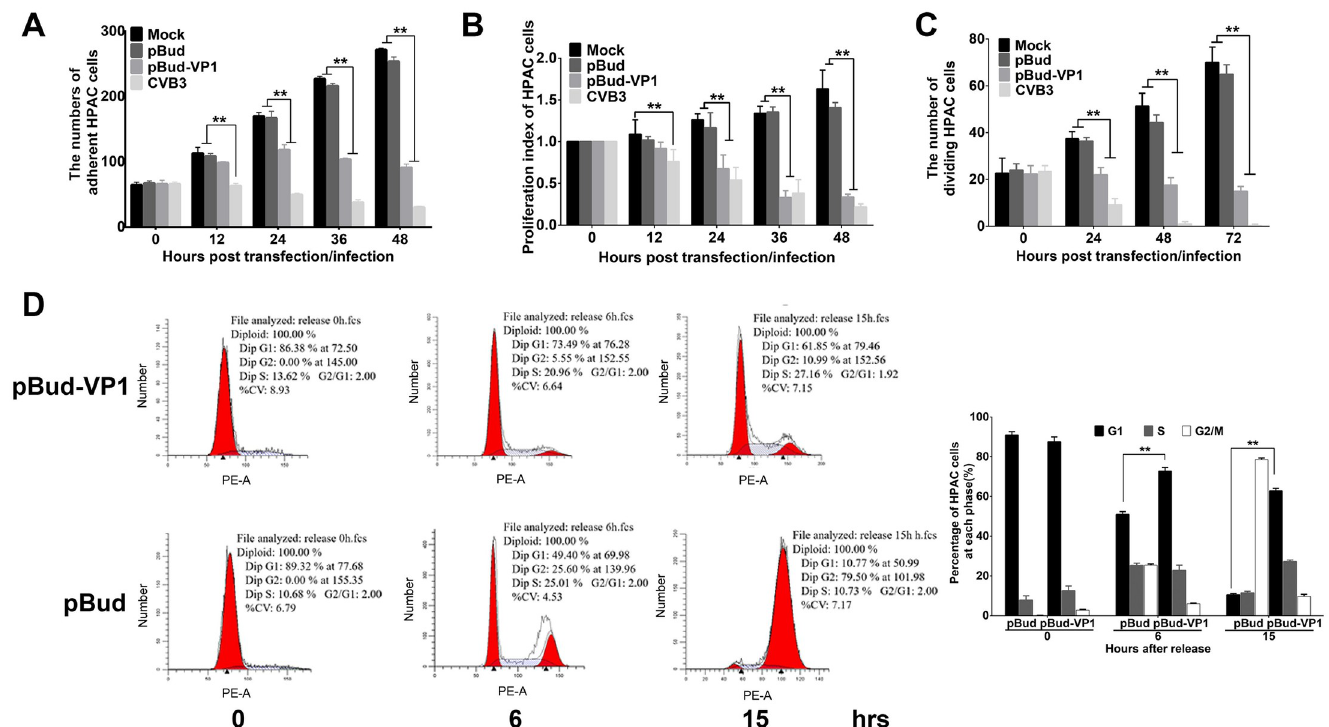
Fig 1. CVB3 VP1 affects cell proliferation and blocks cell cycle at the G1/S phase. (A) The numbers of adherent HPAC cells in different groups were counted using Image Pro Plus (IPP) software. (B) HPAC cells were transfected by pBud-VP1 and pBud plasmids, and the cell proliferation was evaluated using the CCK-8 assay. (C) The activity of DNA replication was examined using EdU incorporation in HPAC cells. (D) G1/S phase arrest induced by VP1 transfection. HPAC cells were treated with 36-hour plasmid transfection (pBud and pBud-VP1) within the treatment of double-thymidine, and collected at 0, 6 and 15 hpi separately, then cells were analyzed by flow cytometry. Values are shown as the mean ± SEM of three independent experiments. ( � P < 0.05, �� P < 0.01).